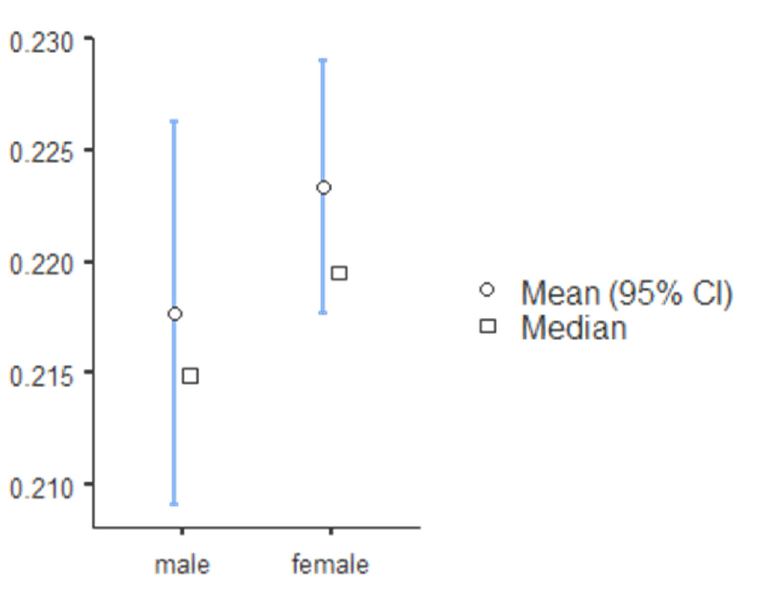
Figure 1. The descriptive chart of mean and median of permanent maxillary right canine index.